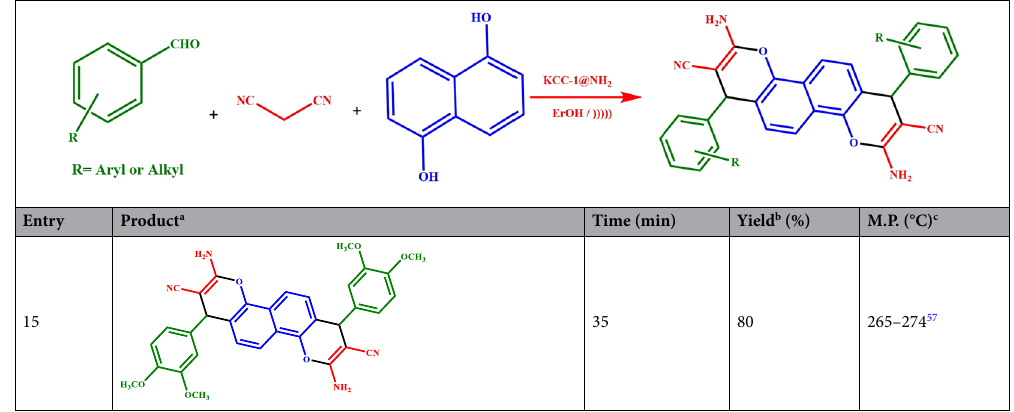
Table 3. Synthesis of 2-amino-4H-chromenes using nanosphere KCC-1@NH 2 . Reactions conditions: benzaldehyde (1 mmol), malononitrile (1 mmol), 1,5-dinaphtol compound (0.5 mmol), nano KCC-1@NH 2 (5%) under ultrasonic irradiation (80 W). a All products were characterized from their spectroscopic IR, 1 H NMR. b Isolated yield. c Literature